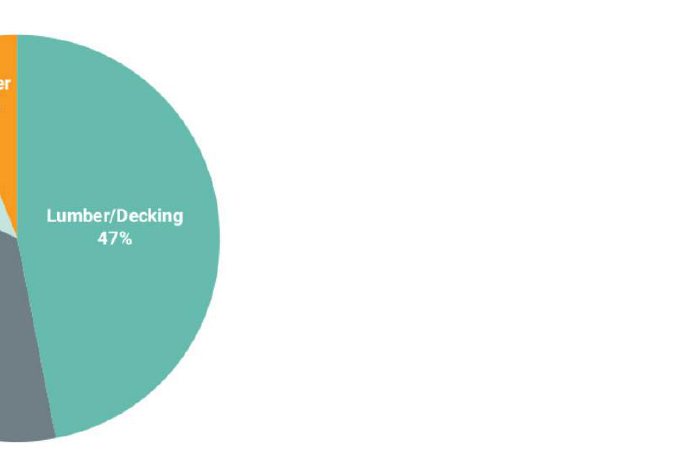
Figure 9. Reclaimed end-uses for U.S post-consumer plastic packaging in 2017. Adapted from [64].